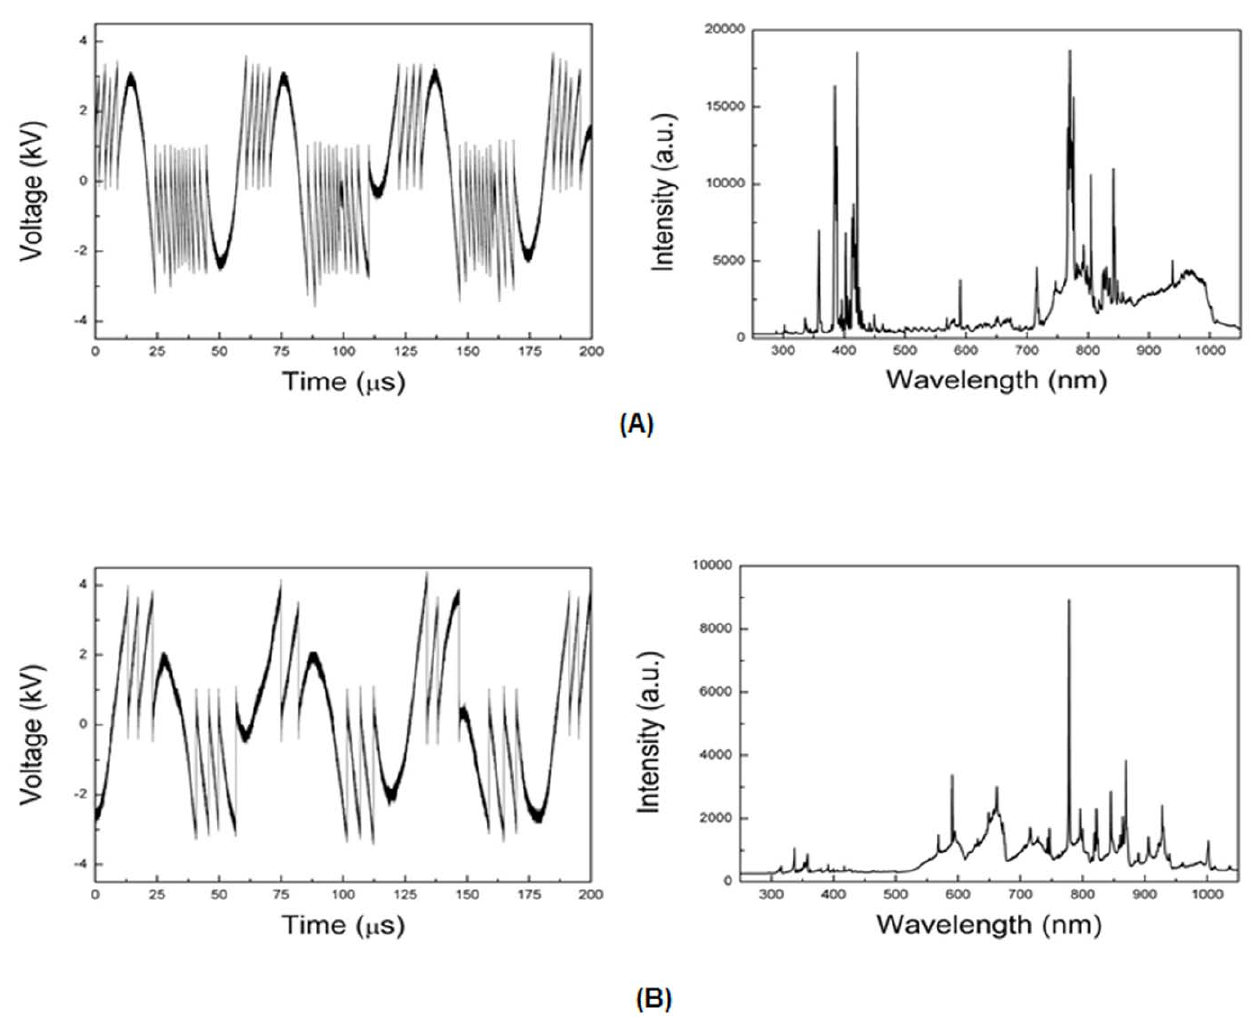
Figure 2. The measured voltage waveforms and optical emission spectra of (A) N 2 and (B) air during discharges at an input voltage of 20 kV p-p .